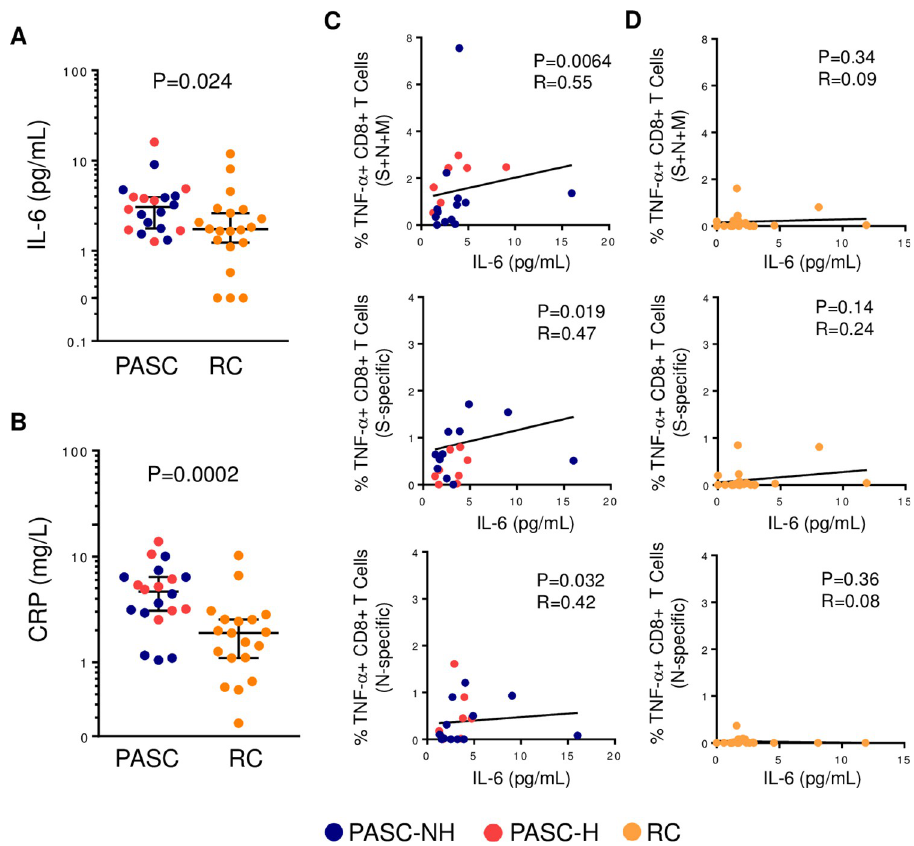
Fig 4. Plasma IL-6 in PASC is higher than RC and correlates with frequency of SARS-CoV-2-specific TNF- α producing CD8 + T cells. (A) Plasma IL-6 levels (pg/mL) and (B) plasma CRP levels (mg/L) in PASC and RC. (C) Correlations between plasma IL-6 and frequency of SARS-CoV-2-specific TNF- α -producing CD8 + T cells in PASC participants. (D) Correlations between plasma IL-6 and frequency of SARS-CoV-2-specific TNF- α -producing CD8 + T cells in RC participants. For A-B, the horizontal bar represents median of cohort and error bars are 95% confidence index. Each point represents data from one participant. Blue: PASC-NH (not hospitalized), red: PASC-Hospitalized and orange: RC participants. For A-B Mann-Whitney tests were used to determine statistical significance. For C-D Spearman correlations were used to determine statistical significance.